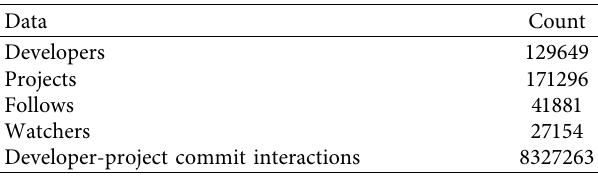
Table 2: The statistics of the